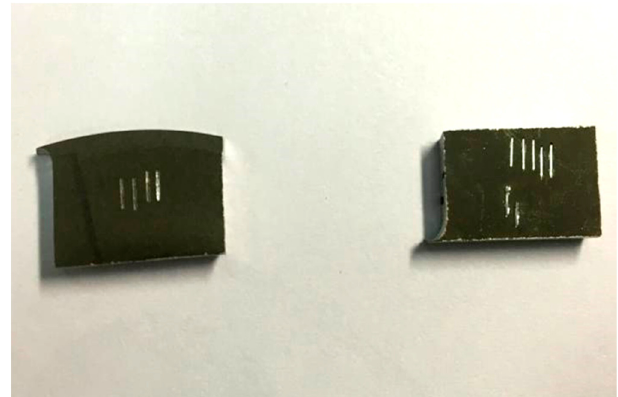
Figure 3. The samples with the anodic oxide film (AOF) and the diamond-like carbon (DLC) film for measuring the adhesion.